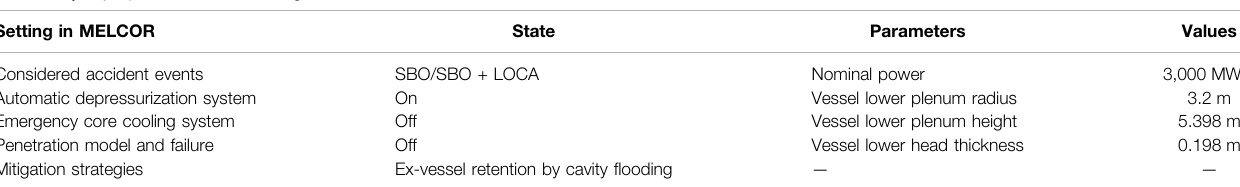
TABLE 2 | Major parameters and settings of the Nordic BWR in